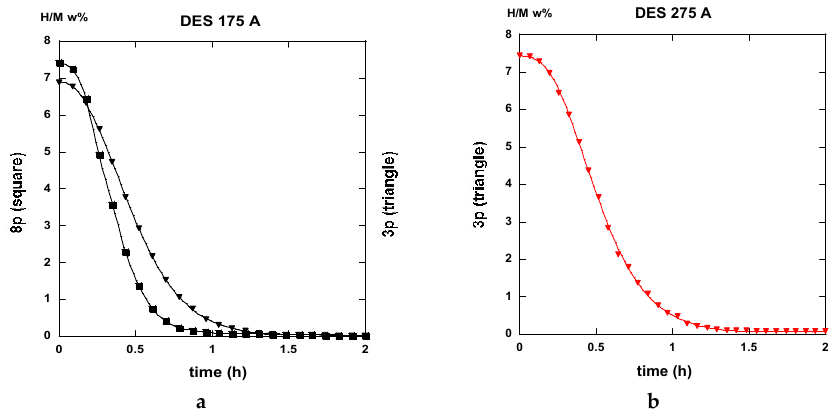
Figure 25. Hydrogen desorption rate (H/M w%) versus time of samples: ( a )—for 3 passes (triangles) and for 8 passes (squares) as treated at 175 ◦ C (black).; ( b )—for 8 passes as treated at 275 ◦ C (red).